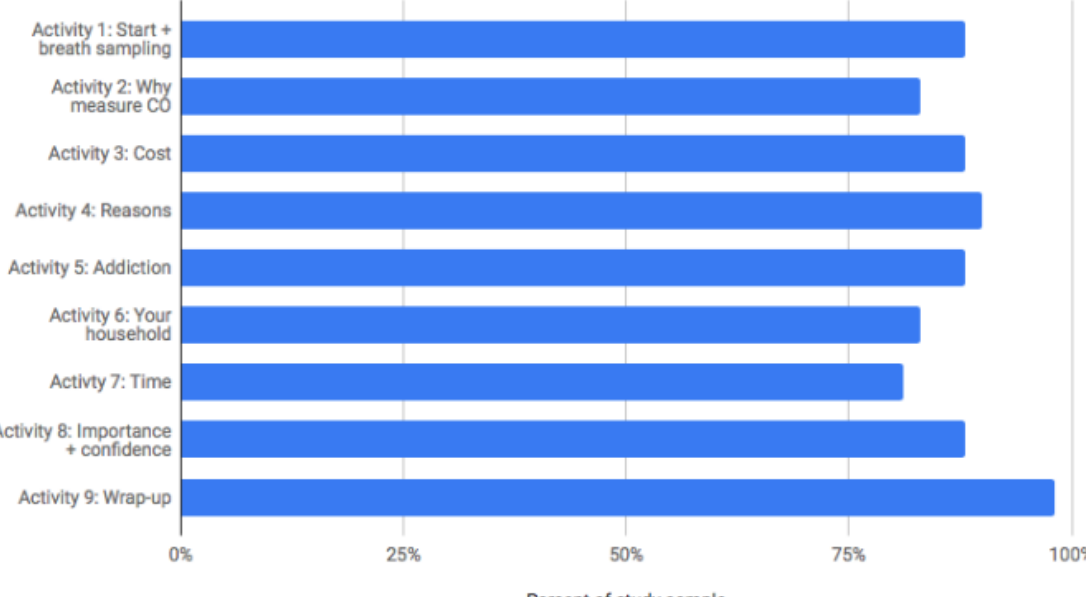
Figure 8. Percent completion of in-app activities. CO: carbon